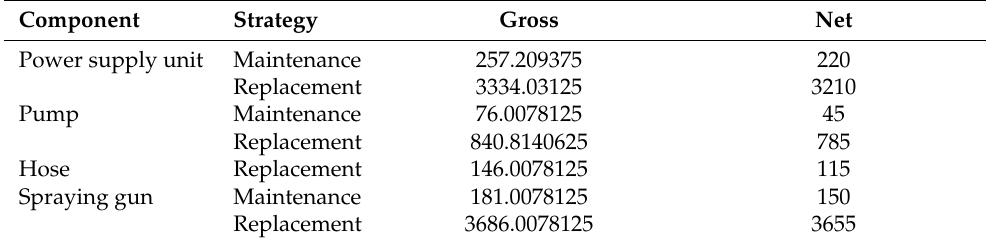
Table 4. Direct costs (EUR) during strategies for the spraying cabin